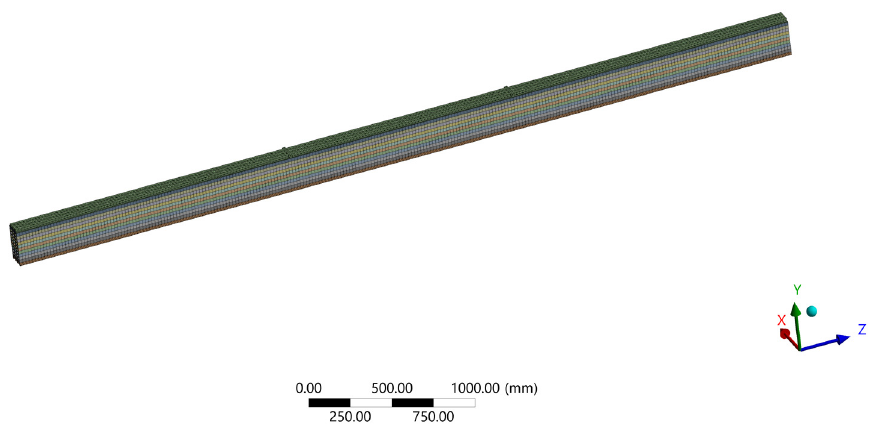
Figure 29. Mesh size.